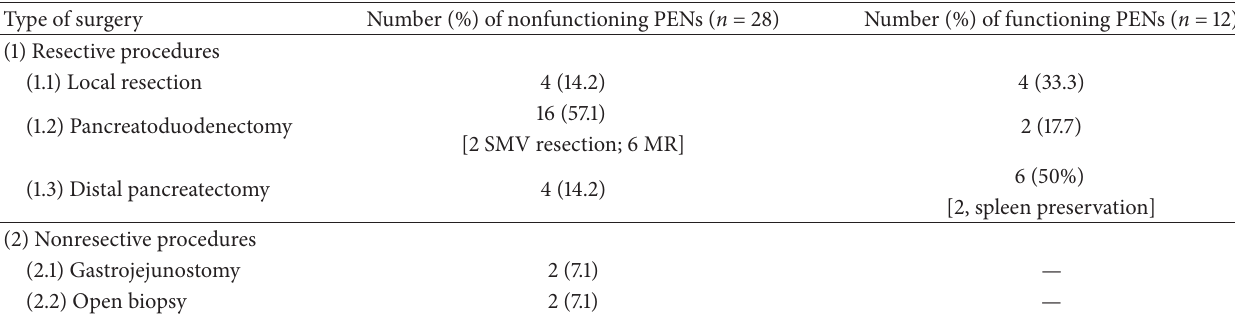
Table 5: Surgeries performed for pancreatic endocrine neoplasms.